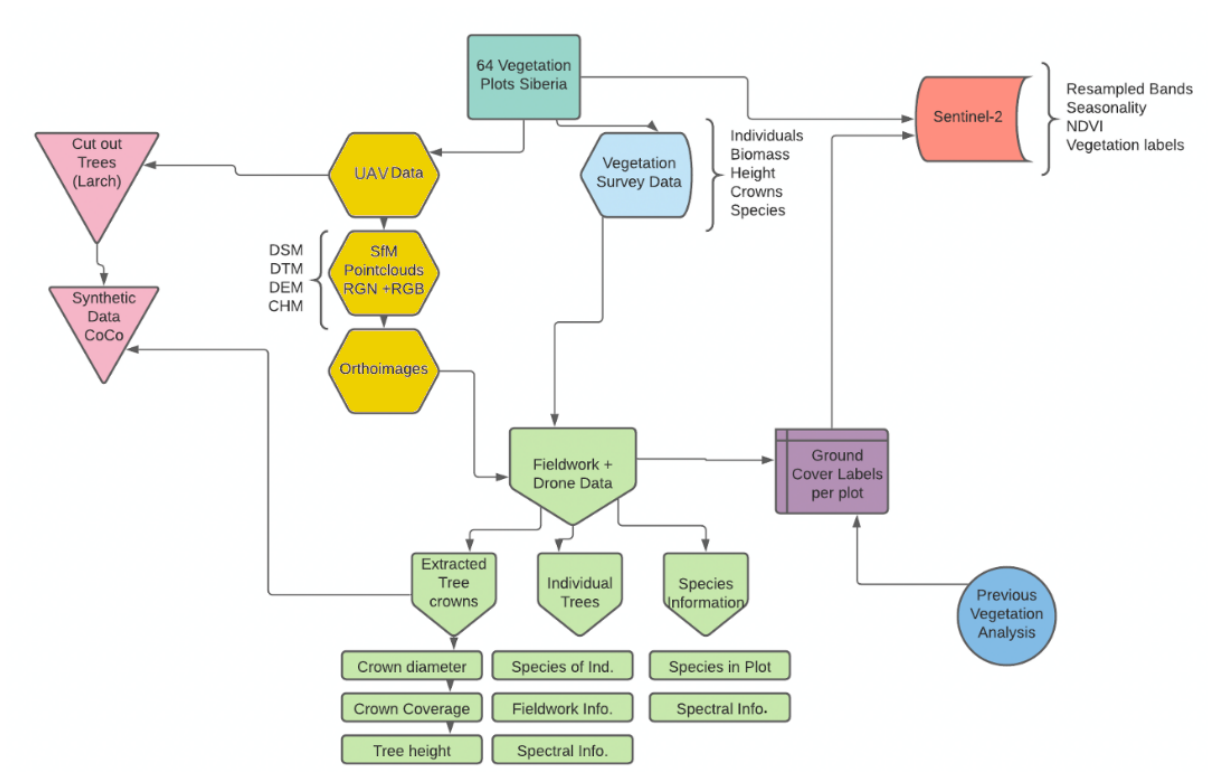
Figure 2. Overview of the four datasets all related to the 2018 expedition plots (UAV-derived products, individually labeled shapefiles, syn- thetically created Siberian larch tree-crown dataset, Sentinel-2 labeled image patches) and their content and interconnections in SiDroForest (see text for details on the labels).